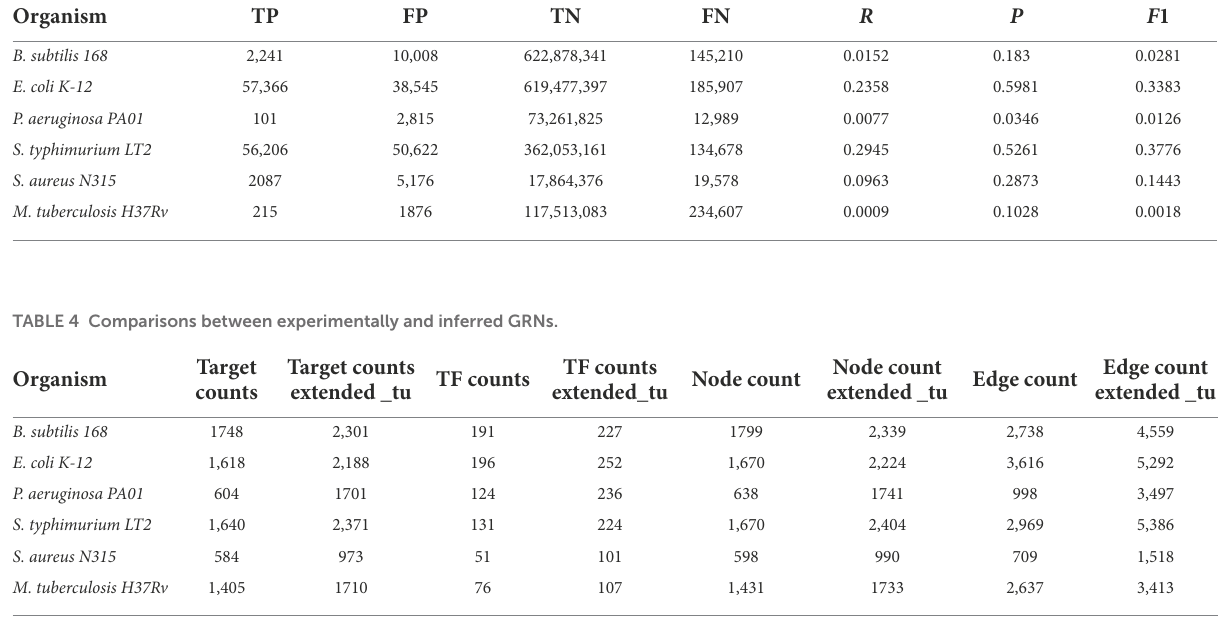
based interface allows the user to select subnetworks and different types of regulatory interactions. Edge and node colors can also be redefined, as well as the layout used in the network visualization, depending on their properties. Additionally, the user can display and visualize information related to Genes (name, protein ID, initial and end coordinates, and strand), and edges among nodes representing genes, including information about whether this is a new or known edge and the organism from which it was derived.